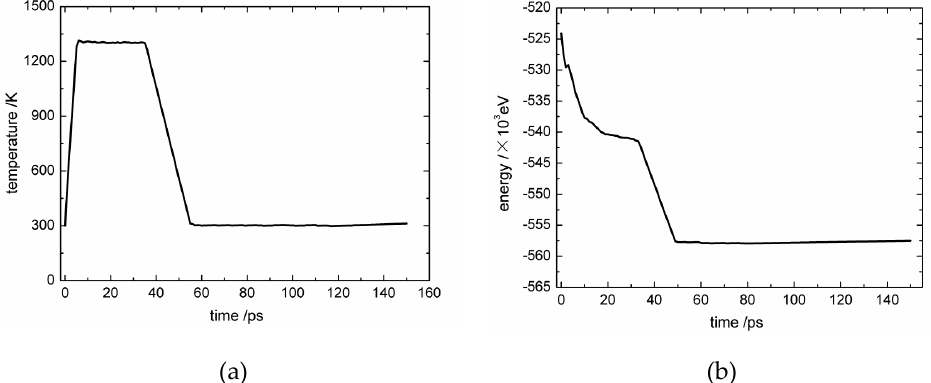
Figure 2. The change in system temperature and total energy with time during annealing: ( a ) system temperature; ( b ) system total energy.